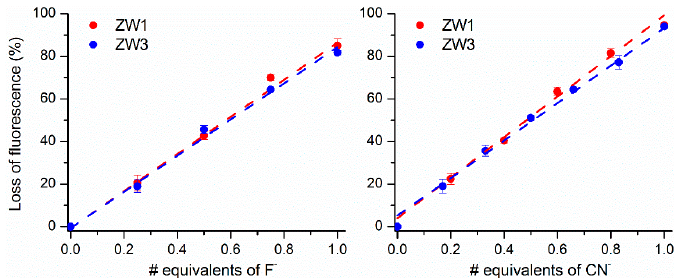
Figure 3. Standard curves for the fluorescence detection of fluoride and cyanide anions using acetonitrile solutions of ZW1 and ZW3 ([ ZW ] = 6 × 10 − 6 M), where the loss of emission intensity measured ( λ exc = 406 nm) upon controlled additions of up to 1 equivalent of tetraethylammonium fluoride (TEAF) and tetraethylammonium cyanide (TEACN) is plotted. Dots correspond to the average Δ F/F 0 values determined after three independent experiments, while lines were obtained after linear fits of this data.